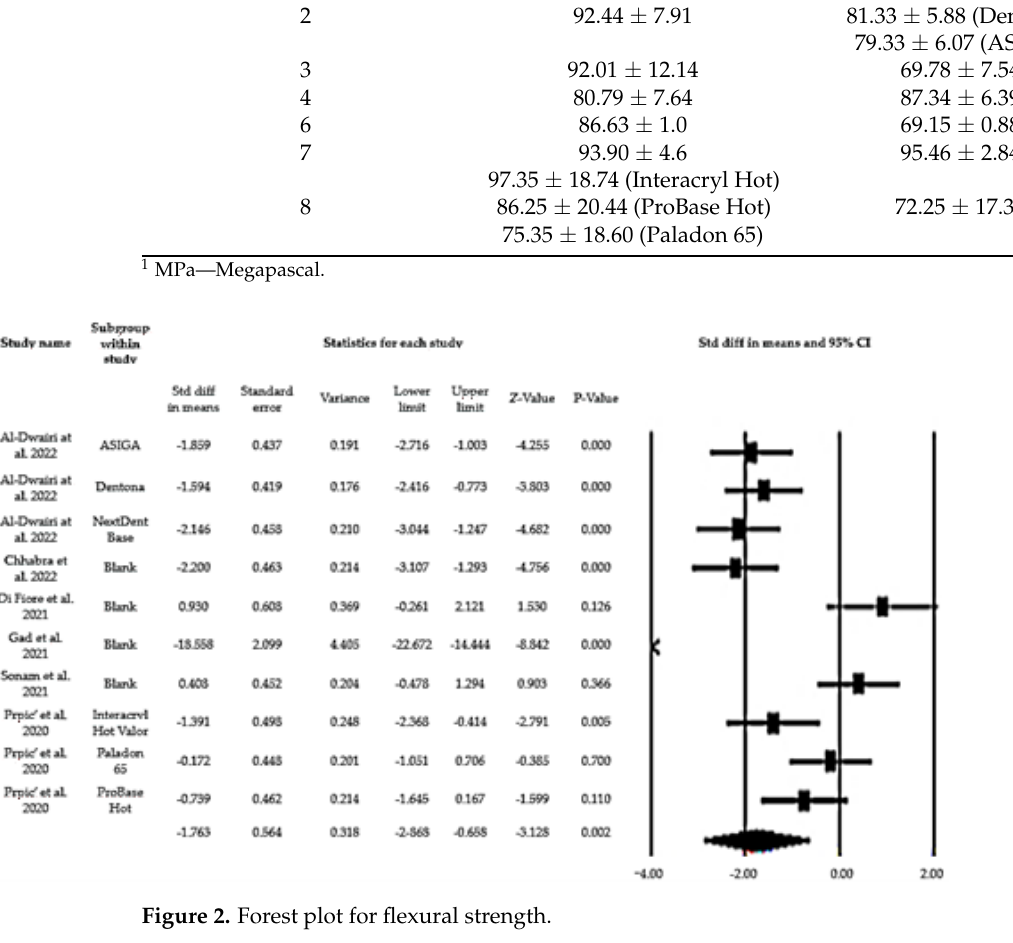
Figure 2. Forest plot for flexural strength.